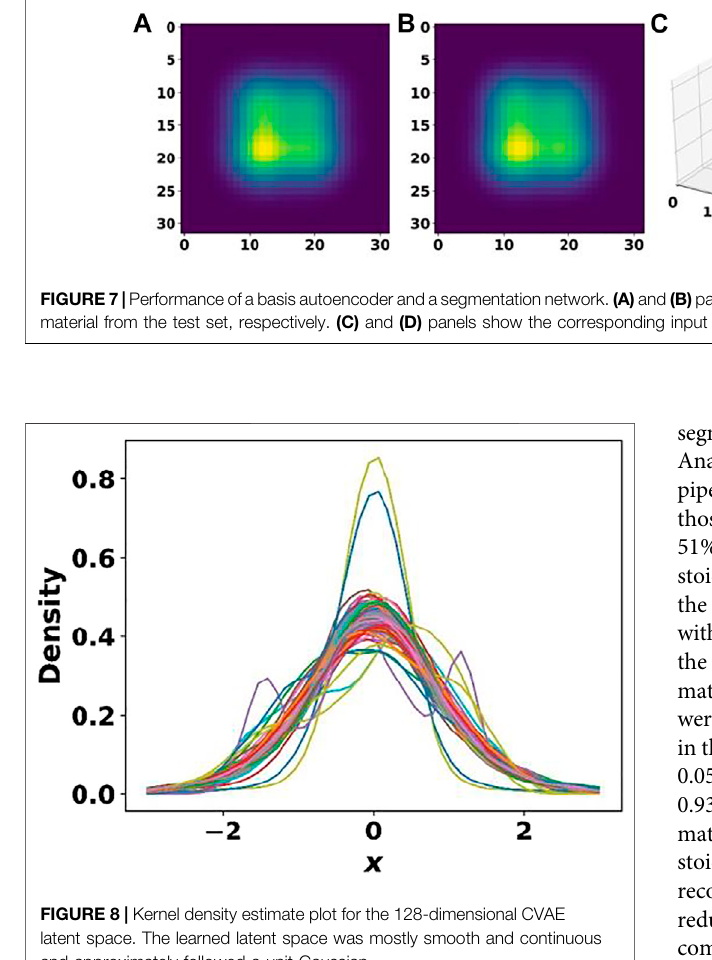
Frontiers in Materials |